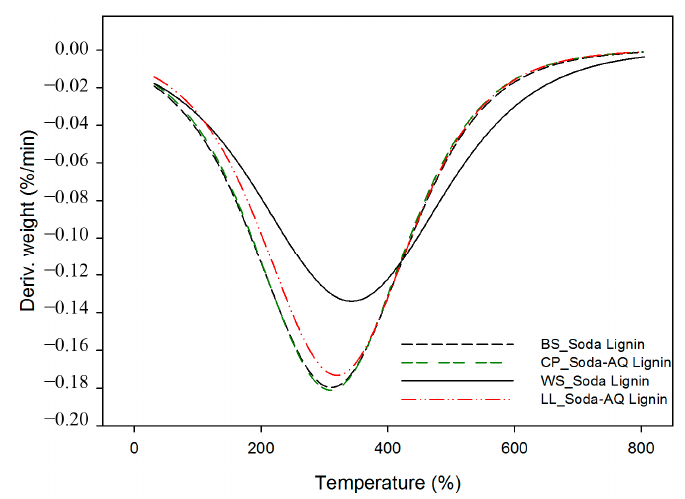
Figure 3. DTG curves of lignin samples obtained from a thermogravimetric analysis (TGA). BS_Soda Lignin, CP_Soda-AQ Lignin, WS_Soda Lignin and LL_Soda-AQ Lignin refer to the lignin samples isolated from barley straw, Chamaecytisus proliferus , wheat straw and Leucaena leucocephala , respectively. Table 3. Thermogravimetric parameters of the different lignin samples.